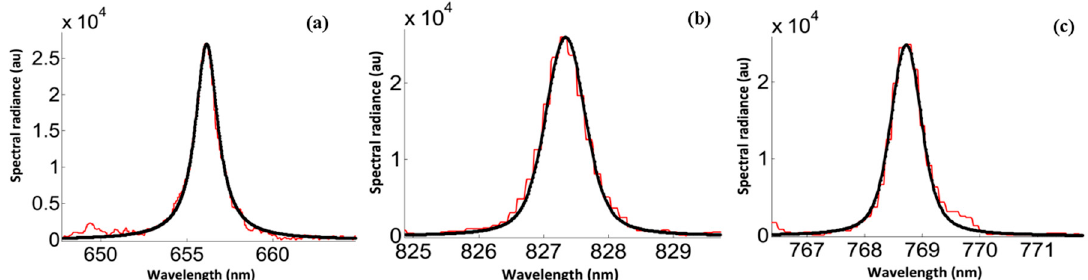
Figure 2. Self-reversal of the resonance Ag I line at 327.9 nm. Laser wavelengths: ( a ) 355 nm, ( b ) 532 nm, and ( c ) 1064 nm. The colored, larger, black, and lower plasma spectra are measured from nano- based and bulk silver targets, respectively.